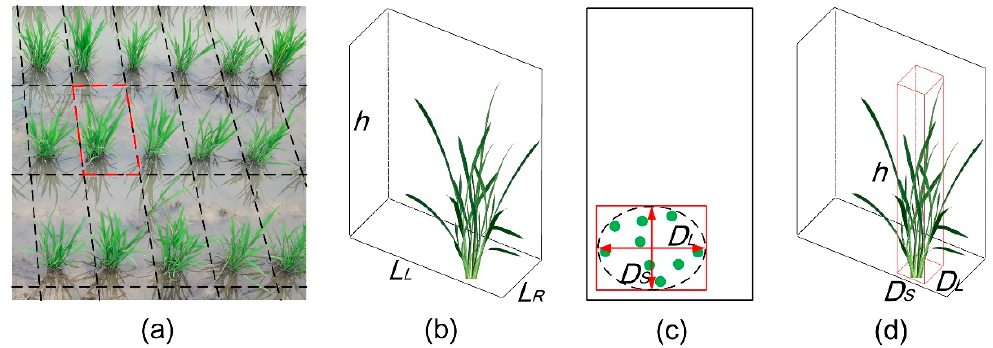
Figure 4. The configuration of a scattering cell. ( a ) The rice field is divided into a large number of scattering cells, as denoted by the red rectangle. ( b ) A scattering cell is regarded as a cuboid with length L L , width L R and height h , which denote the rice plant height, the line, and the row spacing of the rice field, respectively. ( c ) Top view of one scattering cell. The projective point of the lowest leaf node of each stem in a rice cluster constitutes an ellipse (the black dotted line) with the major and minor axes of D L and D S . The external rectangle (the red rectangle) of the ellipse is defined as the projection of the rice part in a scattering cell. ( d ) The rice part is defined as a cuboid in the embrace of a scattering cell, with length D L , width D S , and height h (the red cuboid).